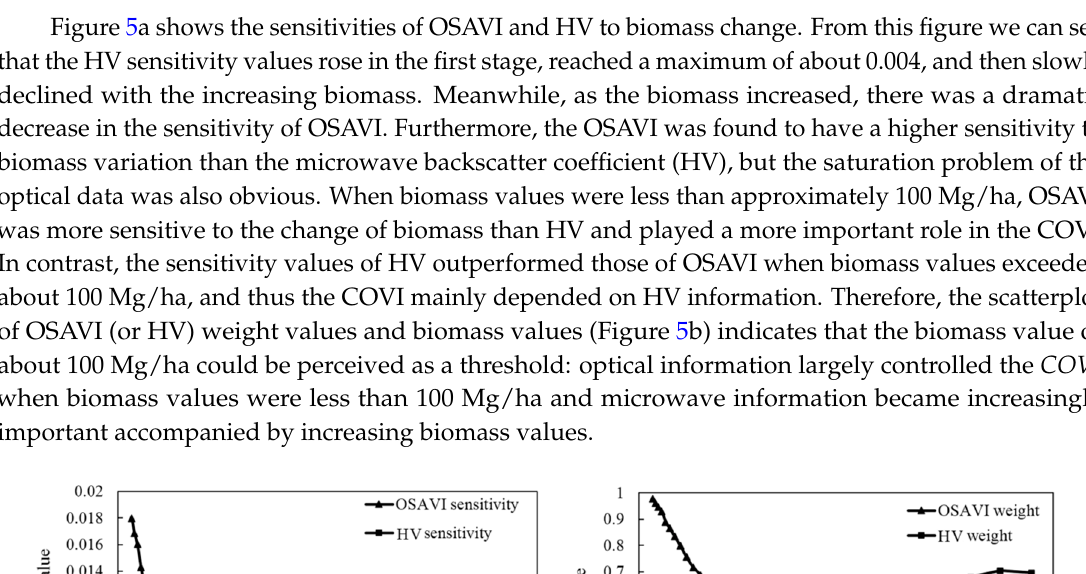
Table 2. Performances of the models (BM) based on COVI and residual optical and microwave optimal variables in Experiment 3 and the models (NBM) which performed best in Experiments 1 and 2.